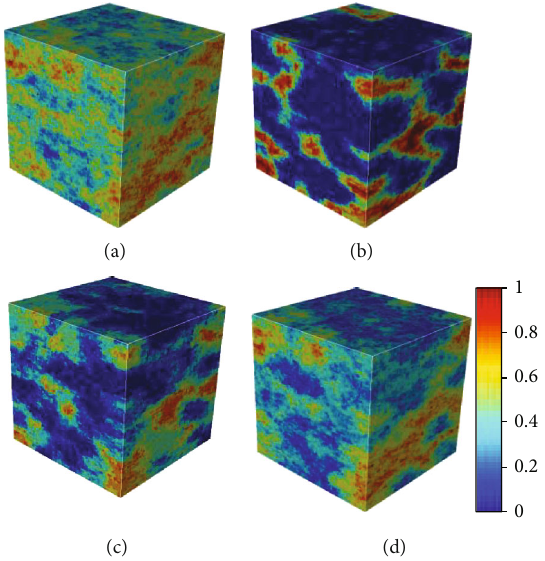
Figure 16: Averages of 10 reconstructed shale images using (a) SNESIM; (b) DTL; (c) FILTERSIM; (d) DISPAT.